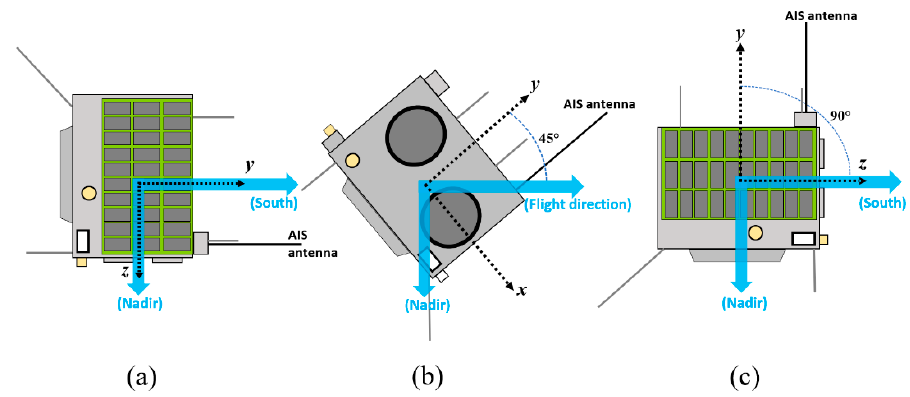
Figure 4. Illustration of LAPAN-A2 maneuvering configuration. ( a ) nadir, ( b ) 45 ◦ -maneuvered, ( c ) 90 ◦ -maneuvered.